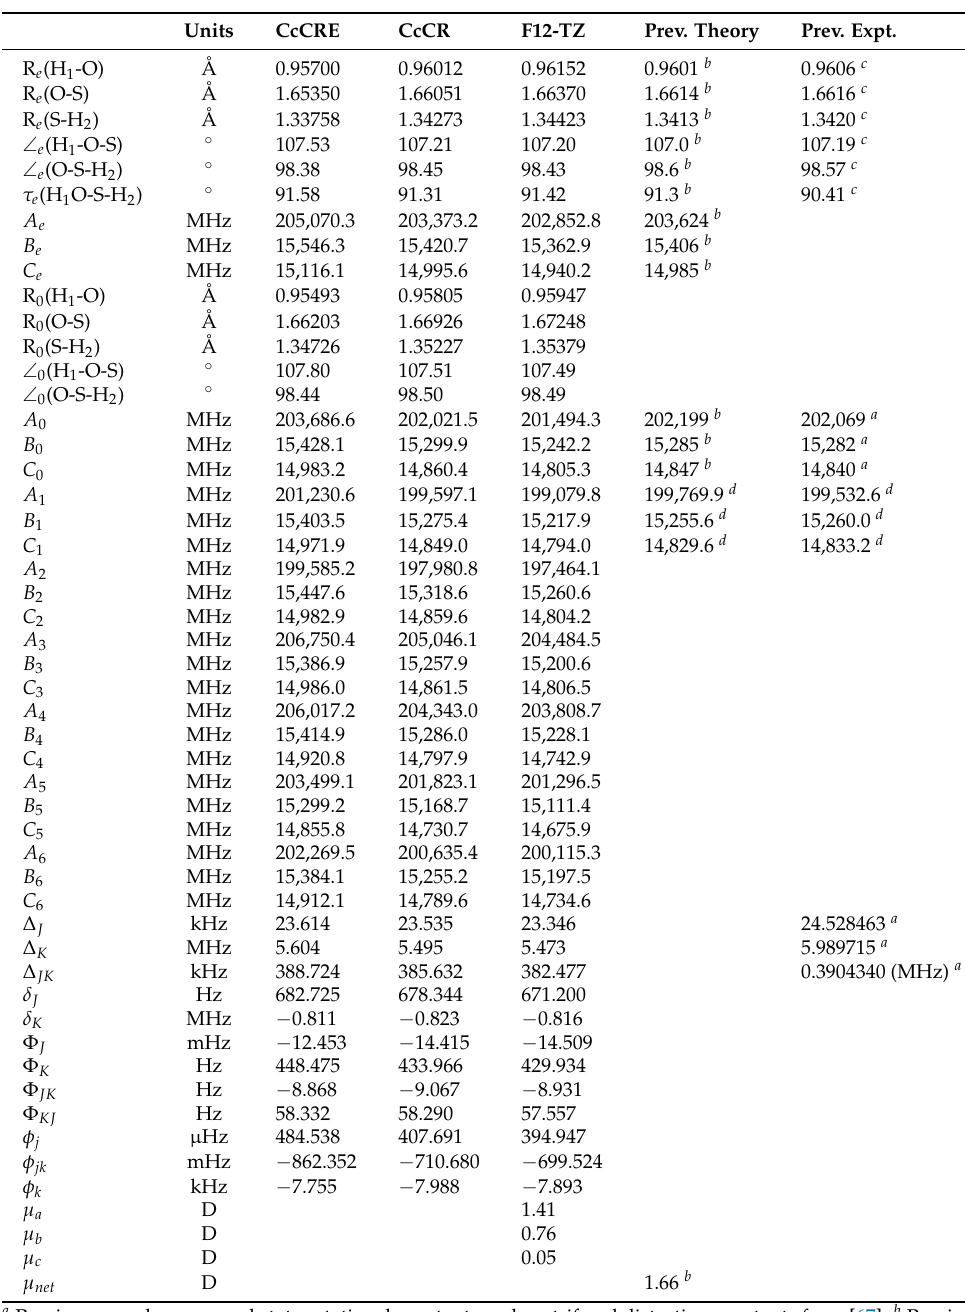
Table 4. Geometrical parameters and spectroscopic constants for HOSH compared to the previous theory and gas-phase